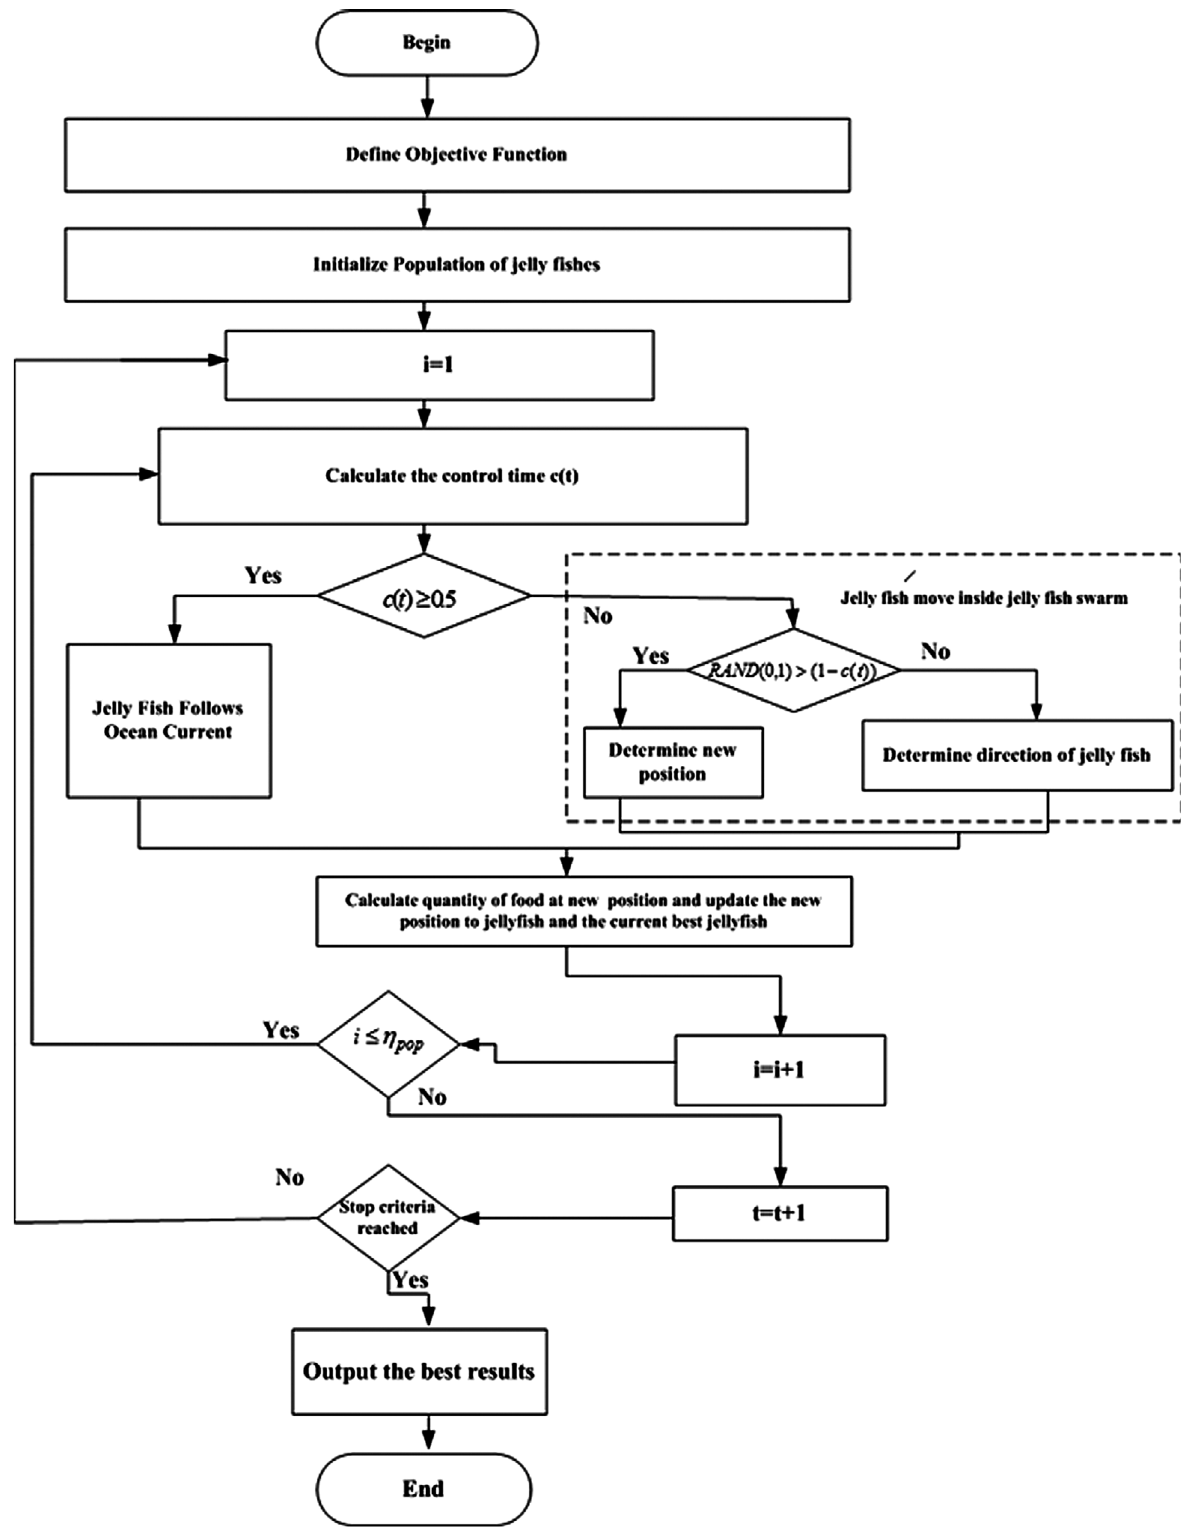
Fig. 6. Flow chart of Jelly Fish (JS)